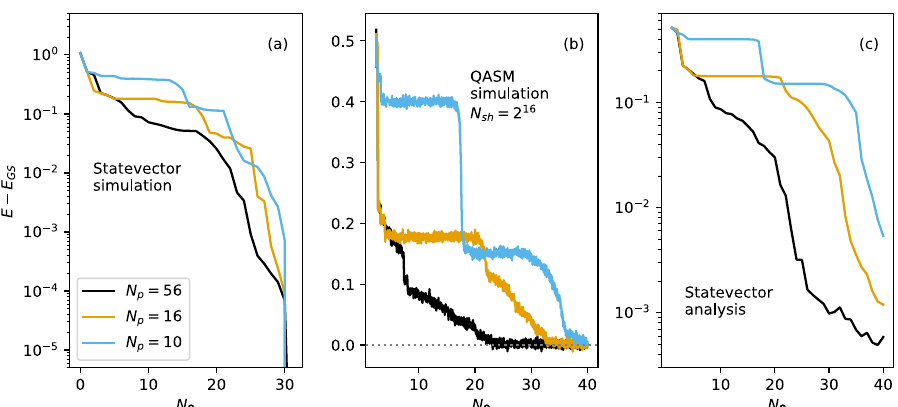
Fig. 6 Pool size dependence of the energy convergence behavior for qubit adaptive derivative-assembled pseudo-trotter (ADAPT) calculations of the e g model. The difference between the exact ground state energy E GS and qubit-ADAPT results as a function of N θ from a statevector simulations and b Quantum assembly language (QASM)-based simulations with N sh = 2 16 shots using three different operator pools of size 56 (black line), 16 (orange line) and 10 (sky blue line), derived from the Hamiltonian commutator pool. The respective energy differences evaluated using statevector for the adaptive ansätze obtained in the noisy simulations of panel ( b ) are shown in panel (